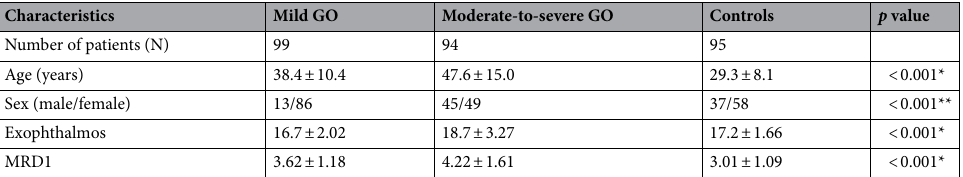
Table 1. Clinical and demographic characteristics of participants. MRD margin reflex distance, GO Graves’ orbitopathy. *One-way ANOVA test. **Pearson’s chi-square test.